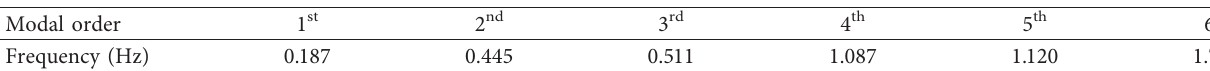
Figure 1: : Model of the SCR: (a) configuration, (b) FE model, and (c) cross-section. Table 1: : Frequency of the SCR.